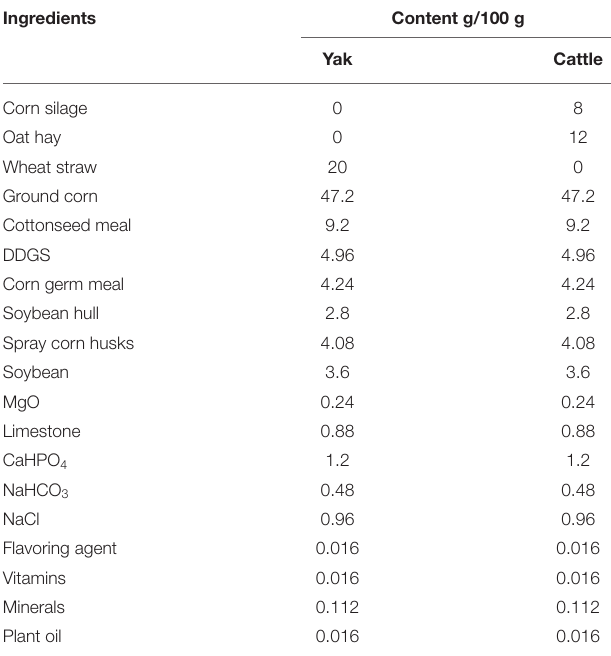
TABLE 1 | Diet composition of feedlot-fattened yaks and feedlot-fattened cattle (DM basis).